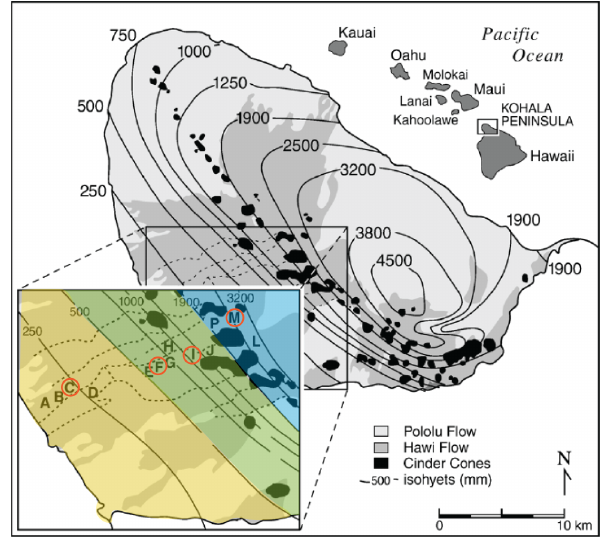
Figure 1. Map of Kohala climosequence sites with respect to rain- fall isoclines, reproduced from Chadwick et al. (2007). Sites sam- pled for this study (C, F, I, and M) are circled in orange. Vegetation zones are highlighted in the inset map: lowland dry scrubland and grassland between 150 and 500mm of rainfall (yellow); lowland dry and mesic forest, woodland, and shrubland from 500 to 2000mm (green); and wet forest and woodland above 2000mm